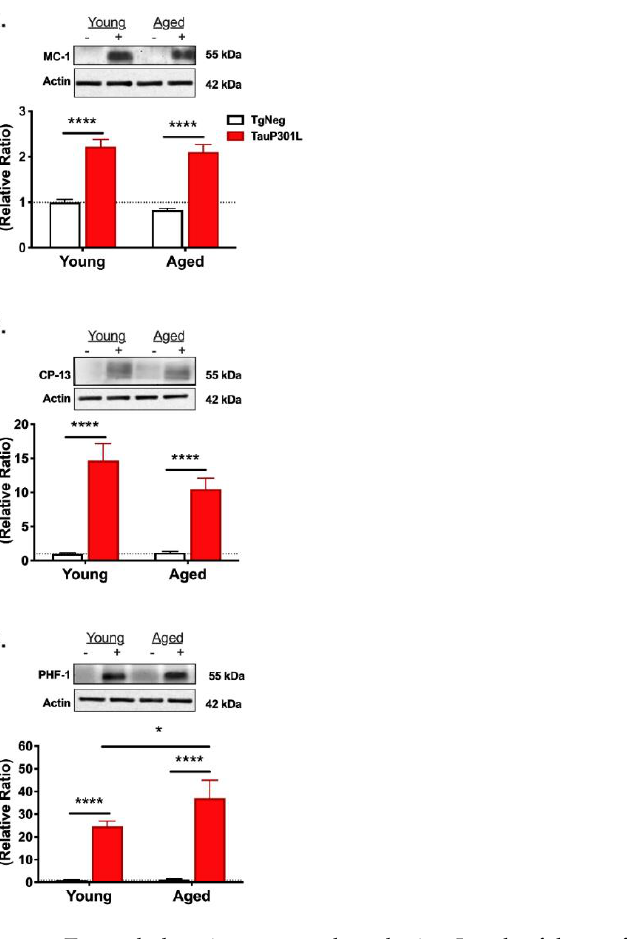
Figure 6. Tau pathology in young and aged mice. Levels of the conformation antibody MC-1 ( A ) and the phosphorylation antibody CP-13 ( B ) were similar between Young-P301L and Aged-P301L mice, whereas Aged-P301L exhibited increased staining with the late-stage antibody PHF-1 ( C ). * p < 0.05; **** p < 0.0001; n = 5 –9/group. − represents TgNeg and + represents P301L.